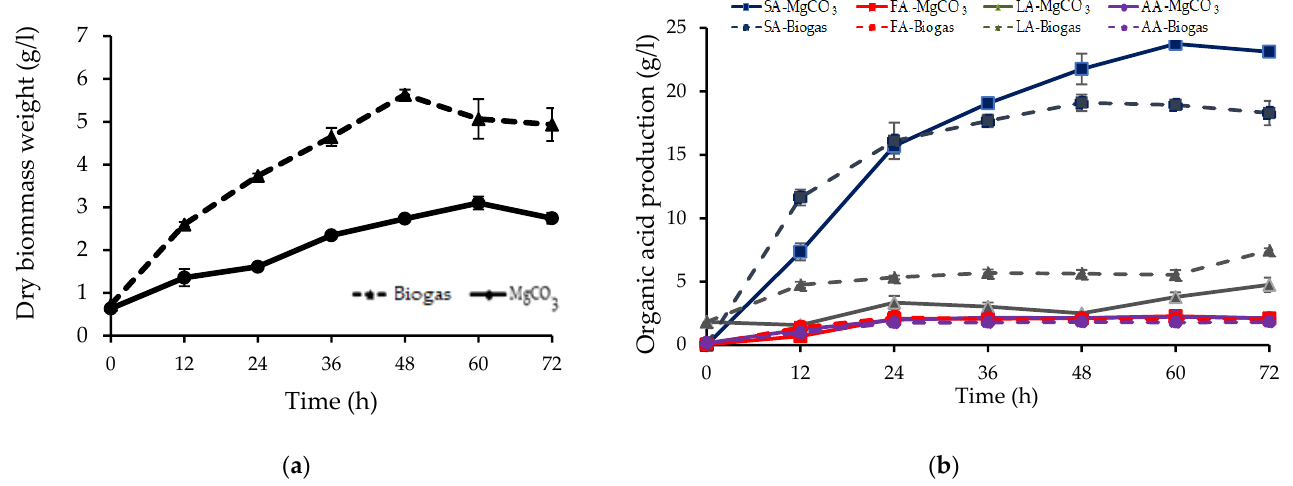
Figure 4. Biomass ( a ) and organic acid ( b ) production from POME supplemented with sparging of biogas (dash line) and MgCO 3 (solid line).